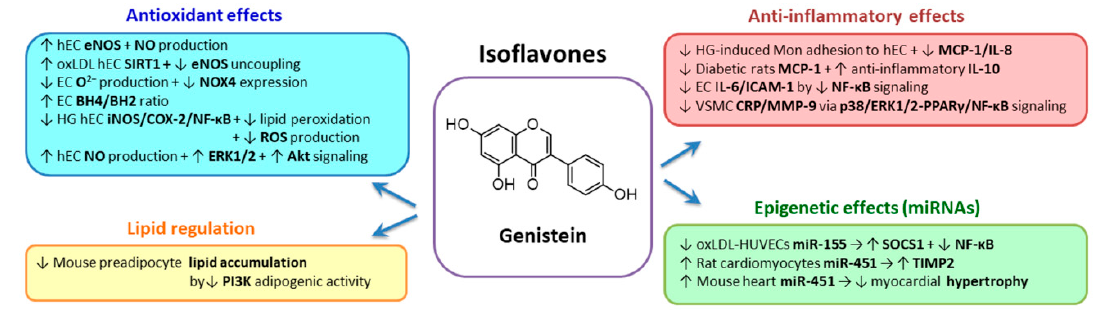
Figure 7. Chemical structure and protective effects of genistein in the context of cardiovascular